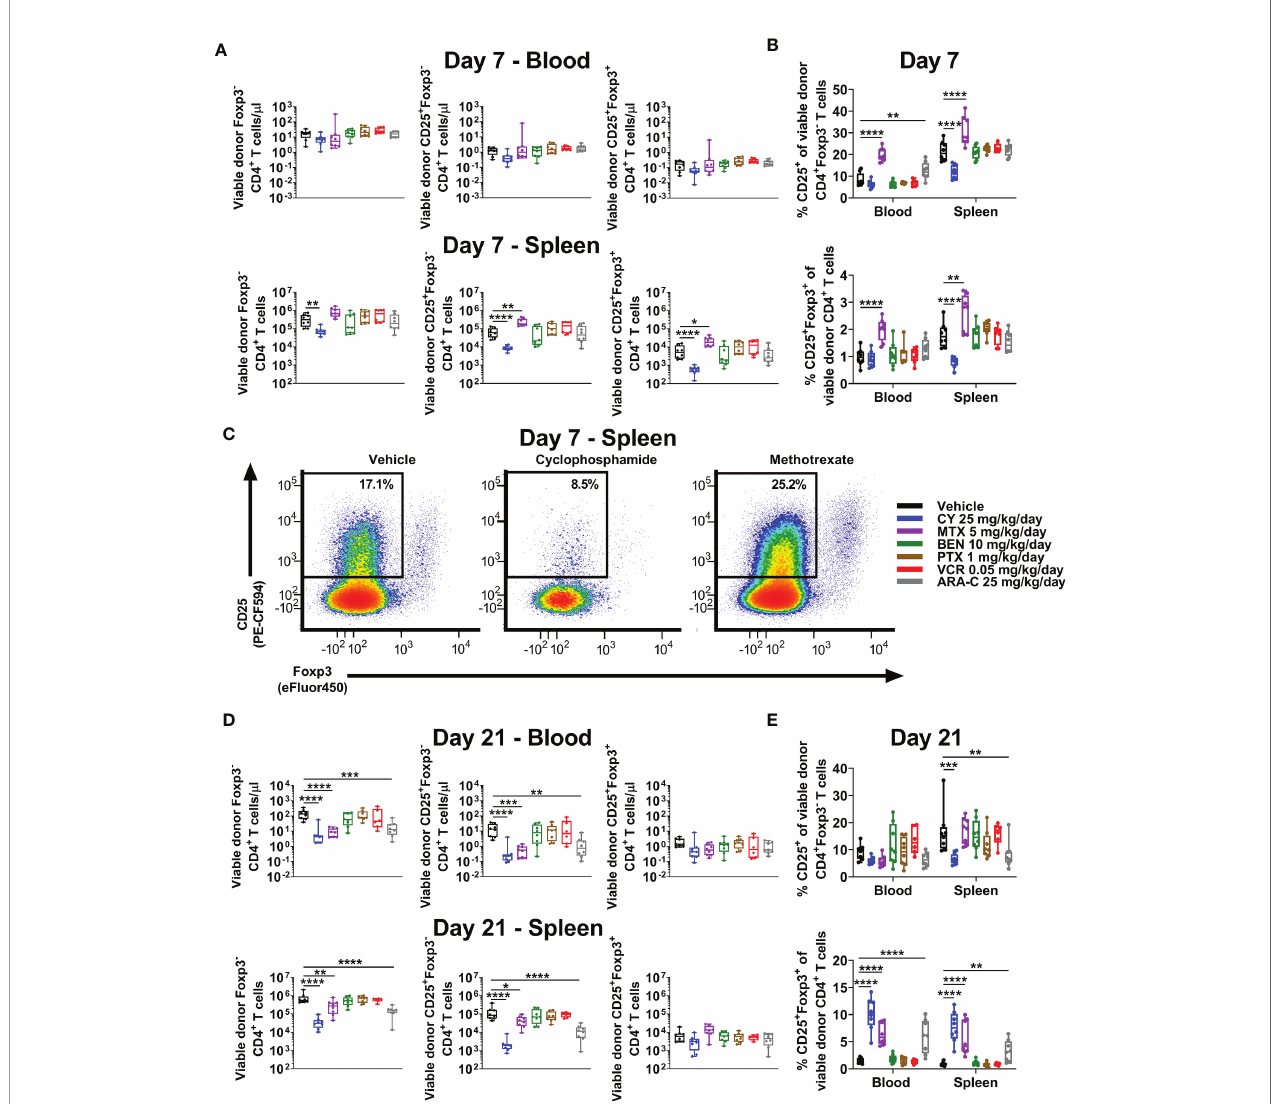
FIGURE 4 | MTX and ARA-C do not control activated conventional CD4 + T cells at day +7, but at day +21 CY, MTX, and ARA-C (all partially effective chemotherapeutics) constrain conventional CD4 + T-cell recovery and facilitate preferential CD4 + CD25 + Foxp3 + regulatory T-cell recovery. Mice were transplanted, treated with PBS or a chemotherapeutic on days +3 and +4, and euthanized for fl ow cytometric assessment at day +7 or +21 as in Figure 3 . (A) At day +7, total numbers of CD4 + T-cell subsets in the blood were not signi fi cantly different across treatment groups, but CY signi fi cantly reduced and MTX signi fi cantly increased total numbers of CD4 + T-cell subsets in the spleen. (B) Although MTX increased percentages of CD25 + Foxp3 + regulatory T cells (T regs ) at day +7 in both the blood and spleen, MTX also signi fi cantly increased percentages of conventional (Foxp3 - ) CD4 + T cells with an activated (CD25 + ) phenotype. This was distinct from CY, which reduced percentages of both. All other chemotherapeutics did not signi fi cantly alter these percentages in comparison with vehicle-treated mice except for ARA-C, which increased percentages of activated (CD25 + ) conventional CD4 + T cells only in the blood. (C) Representative fl ow cytometric plots are shown of CD4 + T cells gated on CD25 versus Foxp3 expression, showing percentages of CD25 + Foxp3 - CD4 + T cells at day +7 that were decreased after CY but increased after MTX. CD25-positivity was gated based on the use of a fl uorescence-minus-one (FMO) control. (D) At day +21, total numbers of Foxp3 - and CD25 + Foxp3 - conventional CD4 + T cells were decreased in mice treated with the partially effective chemotherapeutics (CY, MTX, and ARA-C), whereas total numbers of CD4 + CD25 + Foxp3 + T regs were similar across treatment groups. (E) Due to this balance, CY, MTX, and ARA-C all were associated with increased percentages of CD4 + CD25 + Foxp3 + T regs at day +21, while CY and ARA-C also reduced the percentages of activated (CD25 + ) conventional CD4 + T cells. Combined results from two independent experiments are shown with n = 4/group/experiment for (A – E) except for VCR (n = 6 total) in (D, E) due to excess early deaths. *p < 0.05, **p < 0.01, ***p < 0.001, ****p < 0.0001 on one-way ANOVA followed by the Holm-Sidak post hoc test using the vehicle-treated group as the control. Only signi fi cant results are shown; all other comparisons between treatment groups and the vehicle group are non-signi fi